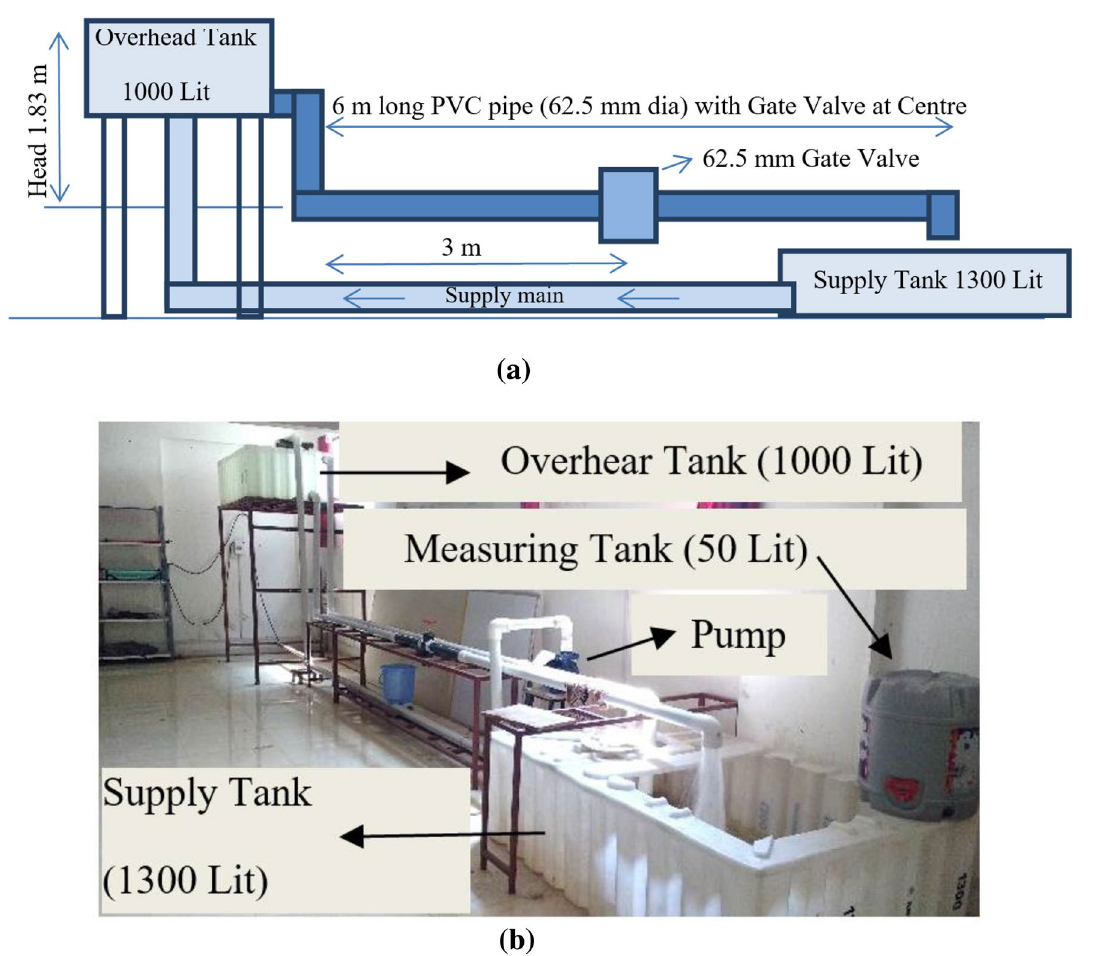
Fig. 3 a Schematic of experimental setup [3]. b Experimental setup of convention and modified gate valve setup [3]